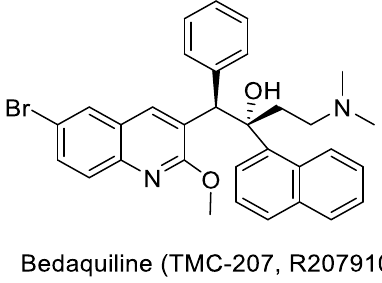
Figure 3. Structure of Bedaquiline (TMC-207, R207910).